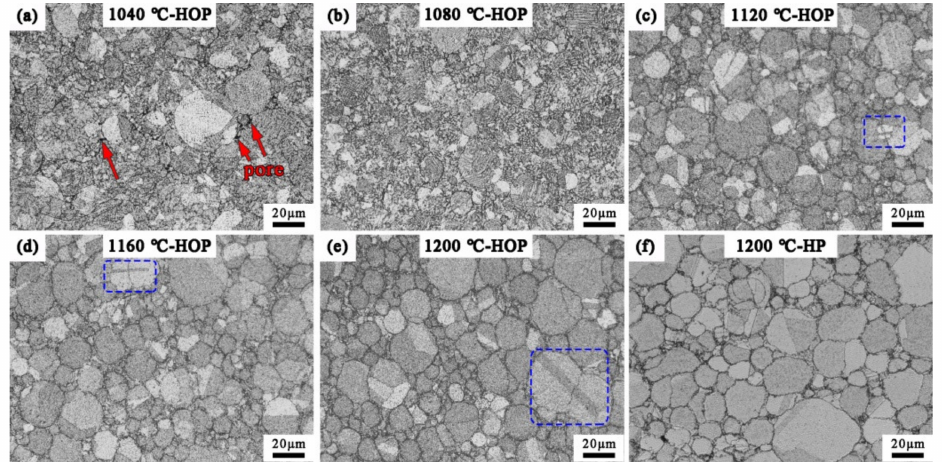
Figure 2. The grain structure of the HOPed and HPed samples: ( a ) 1040 ◦ C-HOP; ( b ) 1080 ◦ C-HOP; ( c ) 1120 ◦ C-HOP; ( d ) 1160 ◦ C-HOP; ( e ) 1200 ◦ C-HOP; ( f ) 1200 ◦